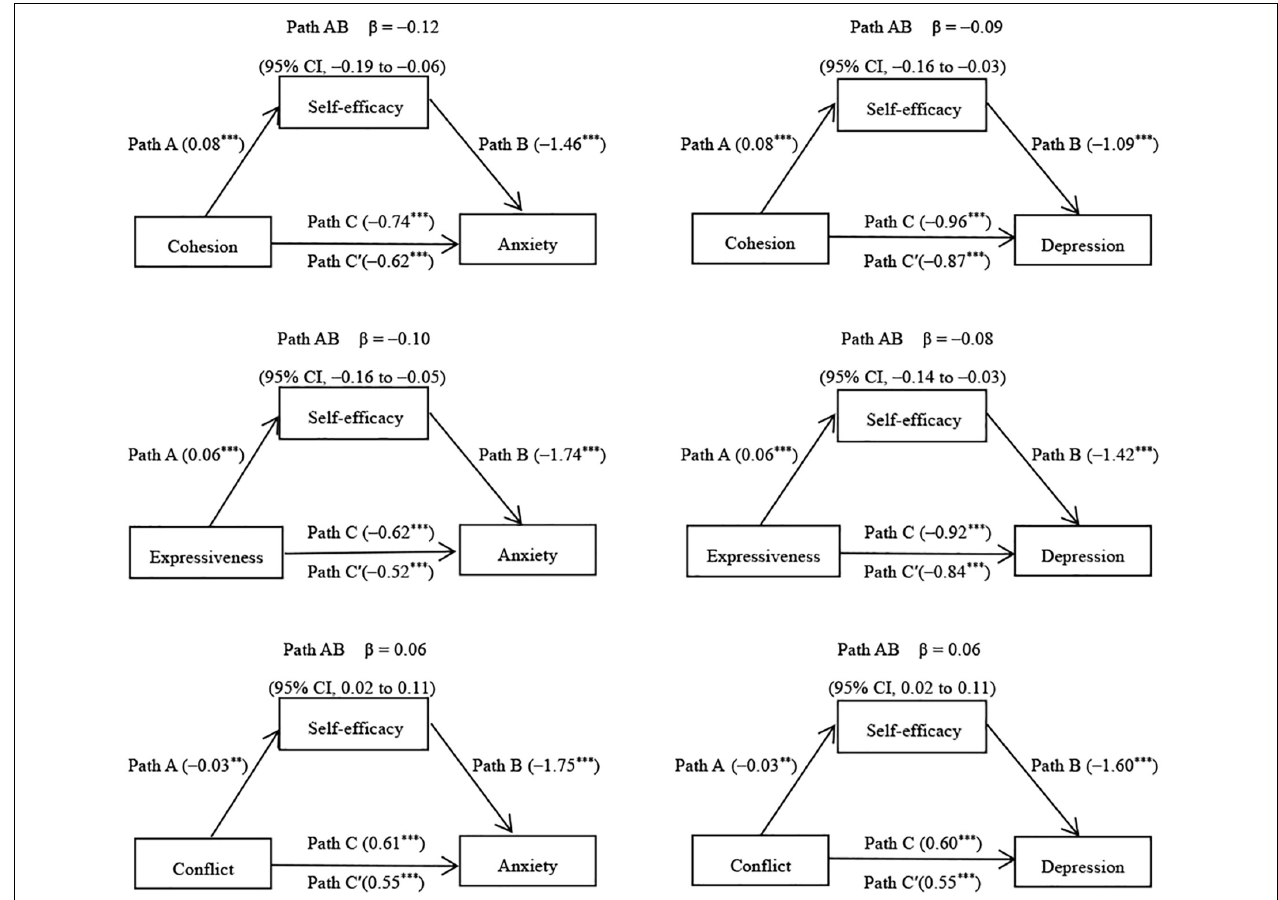
FIGURE 1 | Mediation effects of self-efficacy in the relationship between family environment and the symptoms of anxiety and depression ( N = 645). **P < 0.01; ***P < 0.001.